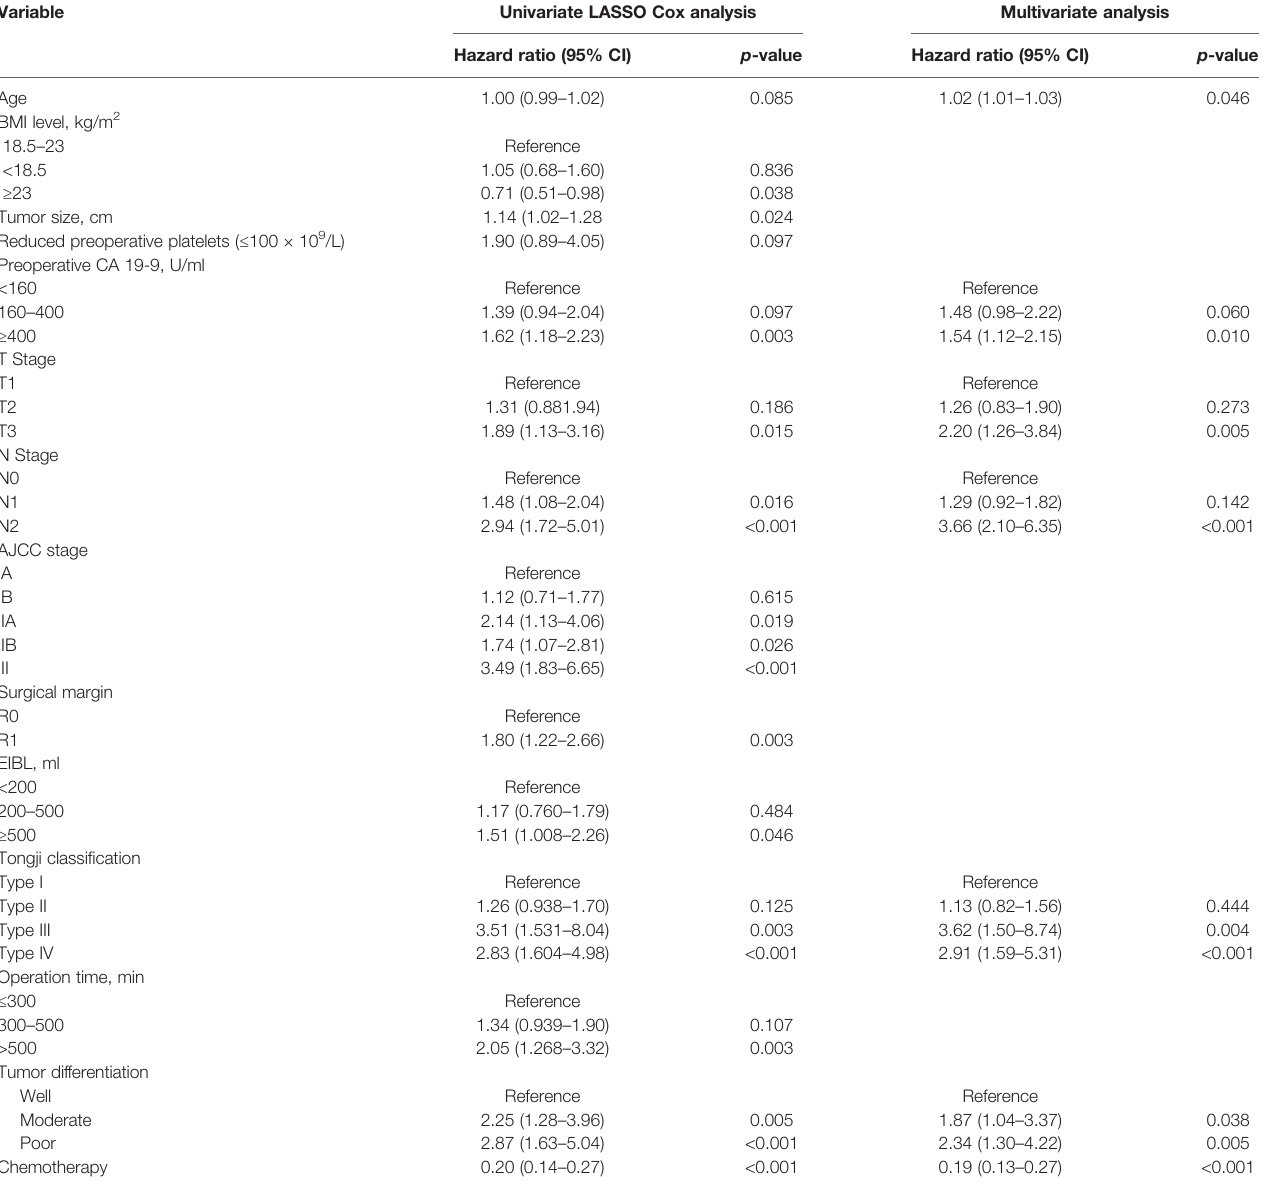
TABLE 2 | Univariate analysis (LASSO Cox) and multivariate Cox proportional hazards regression analysis of the primary cohort. Variable